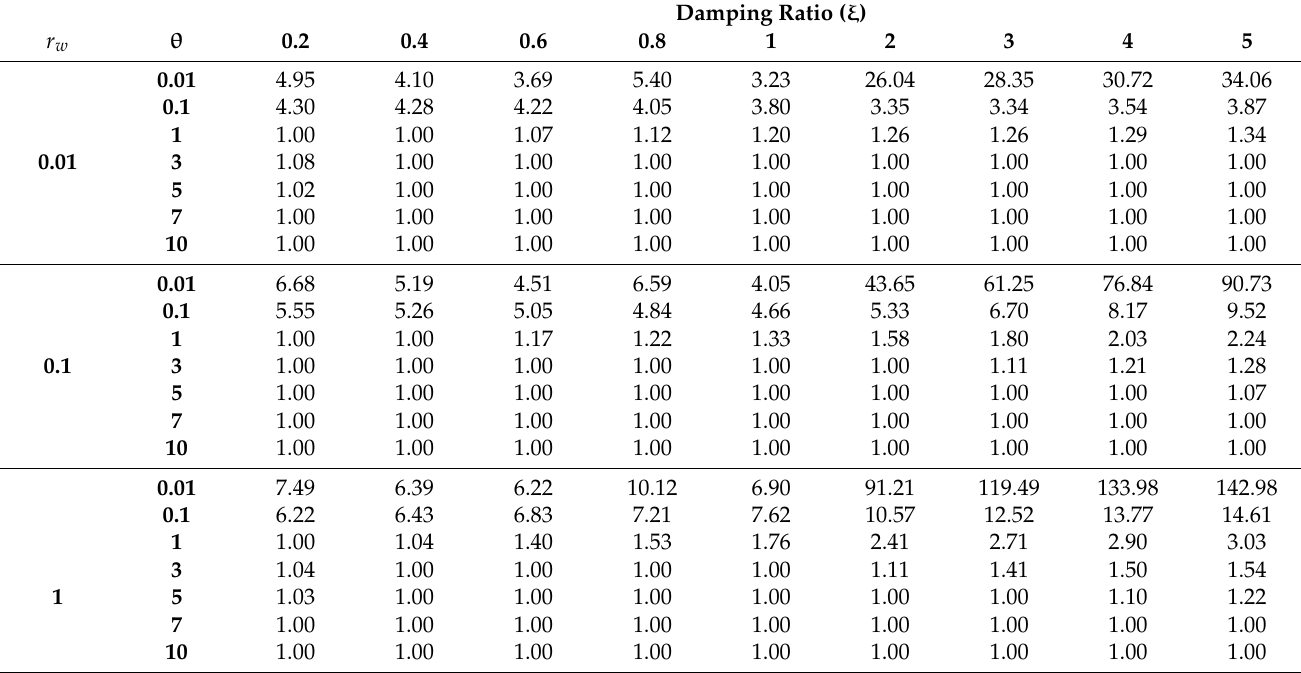
Table 4. Normalized IAE for MPC (Process 1, Disturbance